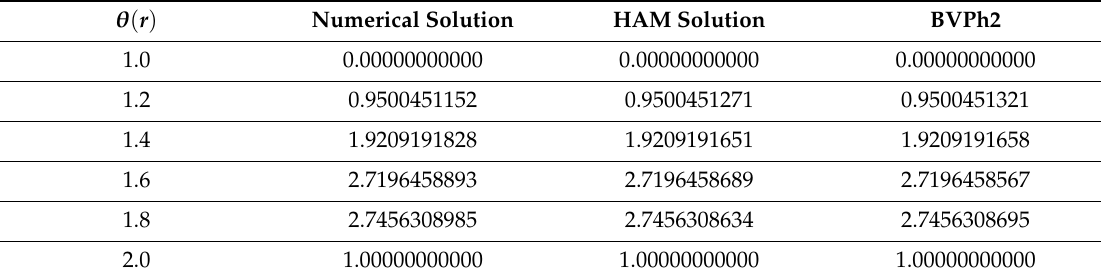
Table 2. Comparison of numerical, HAM, and BVPh2 methods for the temperature